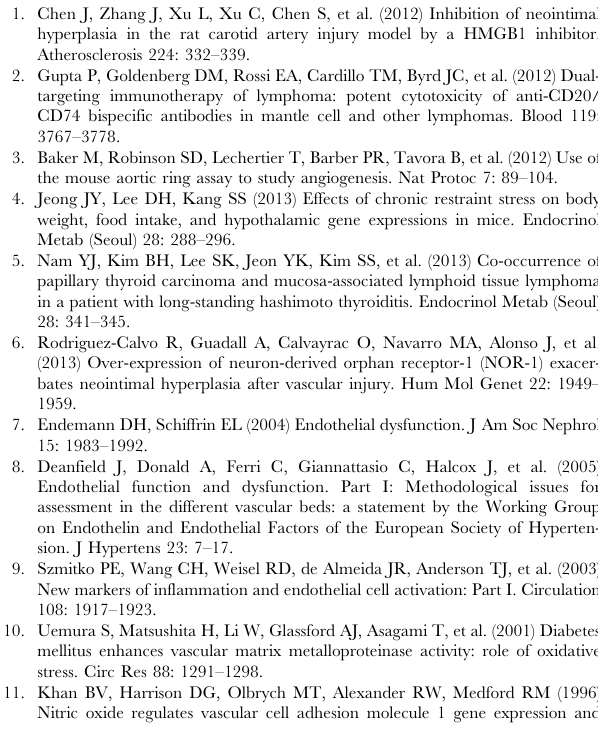
Figure S2 PCA and G15 effects on GPER-1 related mechanism. ( A ) HUVECs in 96 well were treated with adequate substances (PCA, G1, G15, G15 + PCA, G15 + G1) for 1 hr after 2 hrs of serum depletion. Graphs are representative of 3 independent experiments. * indicates P , 0.05 compared to the control and G15 treated group. ( B ) HUVECs were pretreated with adequate substances for 24 hrs (PCA, 100 m M; G1, 3.0 m M). Then G15 (3.0 m M) were added for 6 hrs for p-AMPK and AMPK. Blots are representative of 3 independent experiments. * indicates P , 0.05 compared to the control group. # indicates P , 0.05 compared to the G15